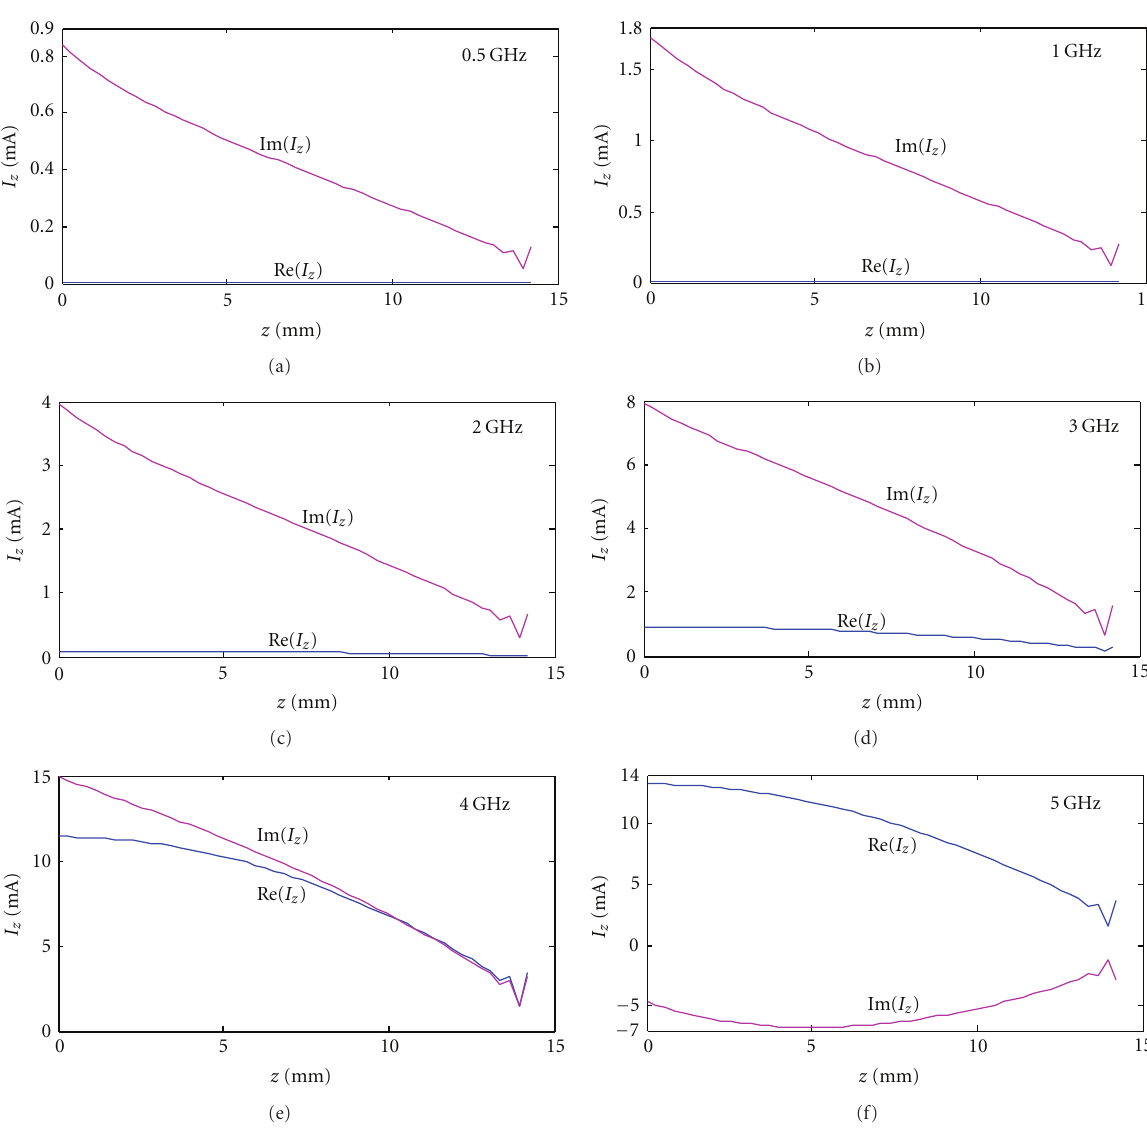
Figure 5: Simulated distribution current, I z , on the 1.436 cm of monopole driving from coaxial line with a = 0 . 65mm and b = 2 . 05